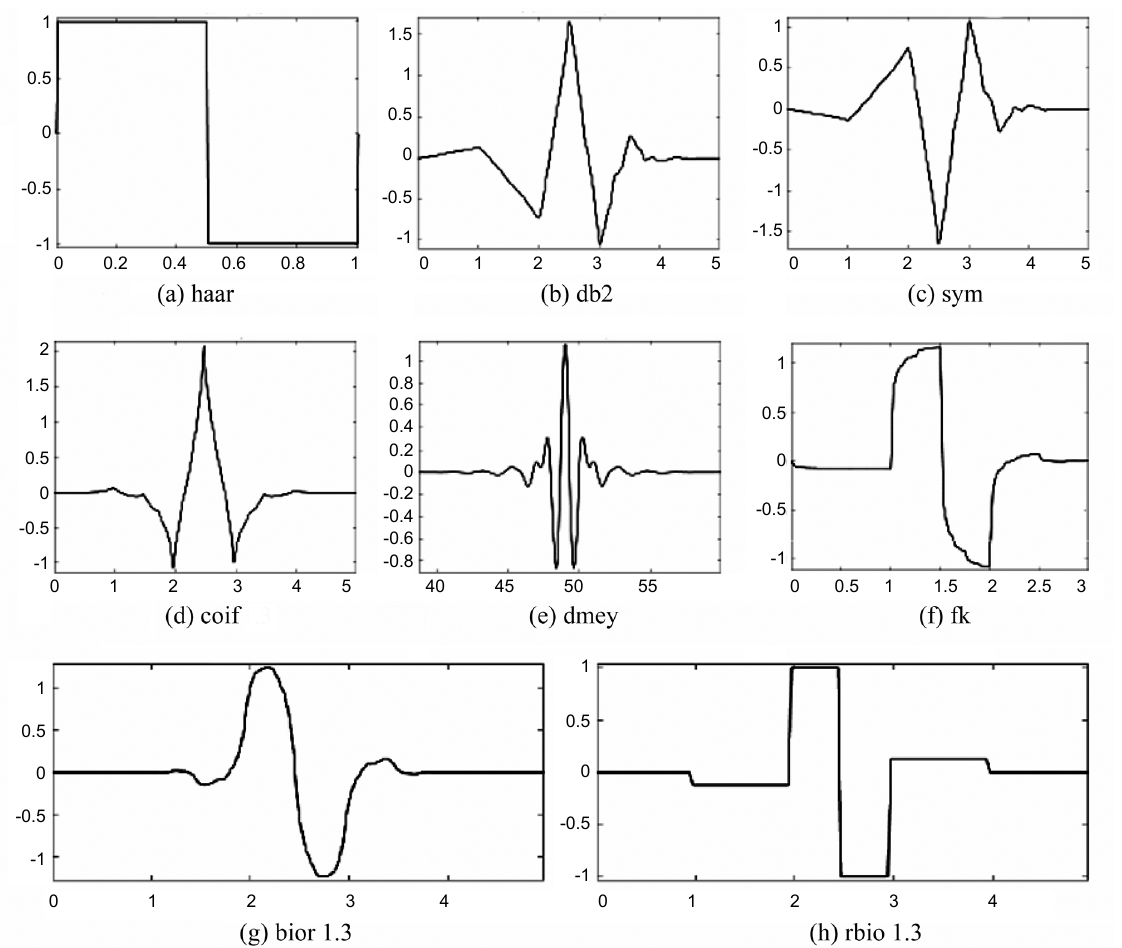
Fig. 2. Wavelet families: (a) haar, (b) db2, (c) sym, (d) coif, (e) dmey, (f) fk, (g) bior1.3, (h)